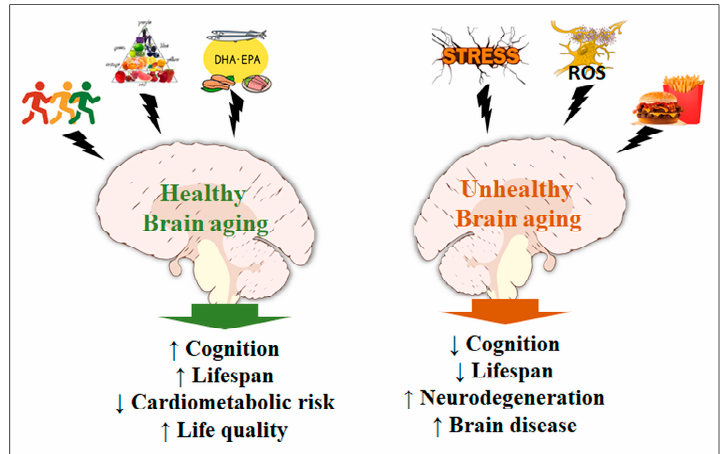
Figure 2. Brain dynamics in healthy and unhealthy aging. Moderate physical activity, low-calorie diets, and essential fatty acids are amongst the main elements of a healthy brain, where we observe less or no cognitive decline, greater lifespan, reduced cardiovascular (and metabolic) risks, and thus overall better quality of life. Conversely, a continuously stressed brain, either by an unstable environment or by chemical mediators (e.g., ROS, reactive nitrogen species and other radicals) will suffer from cognitive decline and increased risk for neurodegeneration and other brain diseases, while affecting the individual’s lifespan. Also, high caloric meals and/or typical cafeteria diets are risk factors for the development of several such affections. ( ↑ ) Increased. ( ↓ ) Decreased.